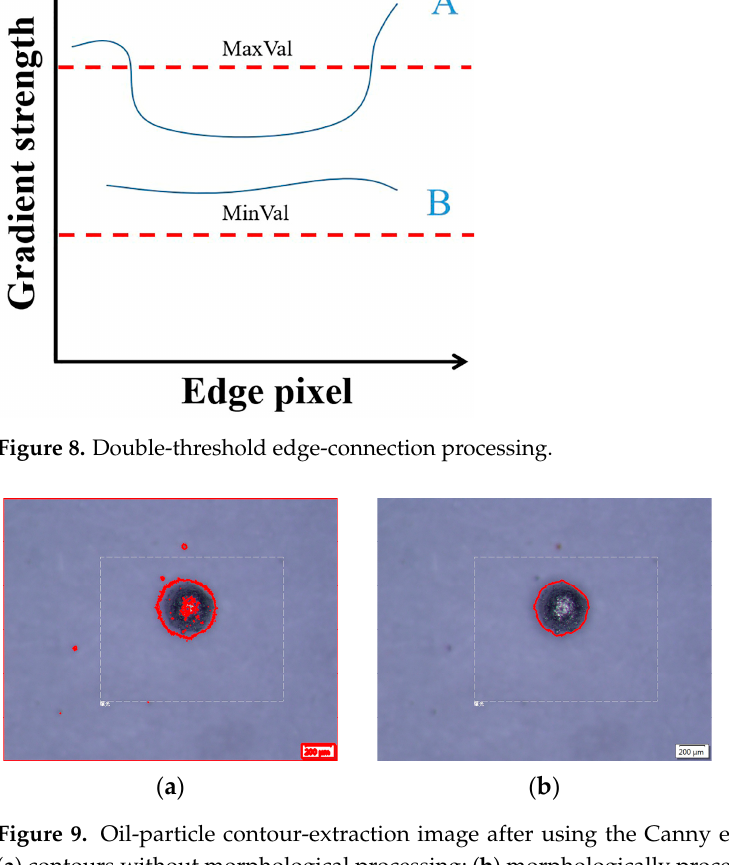
Figure 9. Oil-particle contour-extraction image after using the Canny edge detection algorithm: ( a ) contours without morphological processing; ( b ) morphologically processed contours.